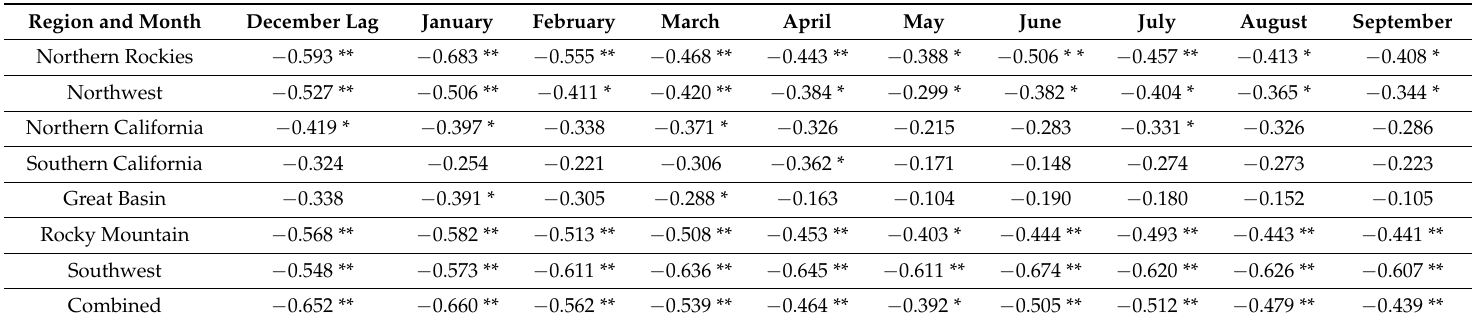
Table 2. Spearman rank-order correlations ( p -values) between monthly total Arctic sea-ice extent and annual wildfire area burned during 1980–2015. Significance for 2-tailed tests with * p <0.05 and ** p < 0.01. Shaded boxes represent month with highest correlation for each region.